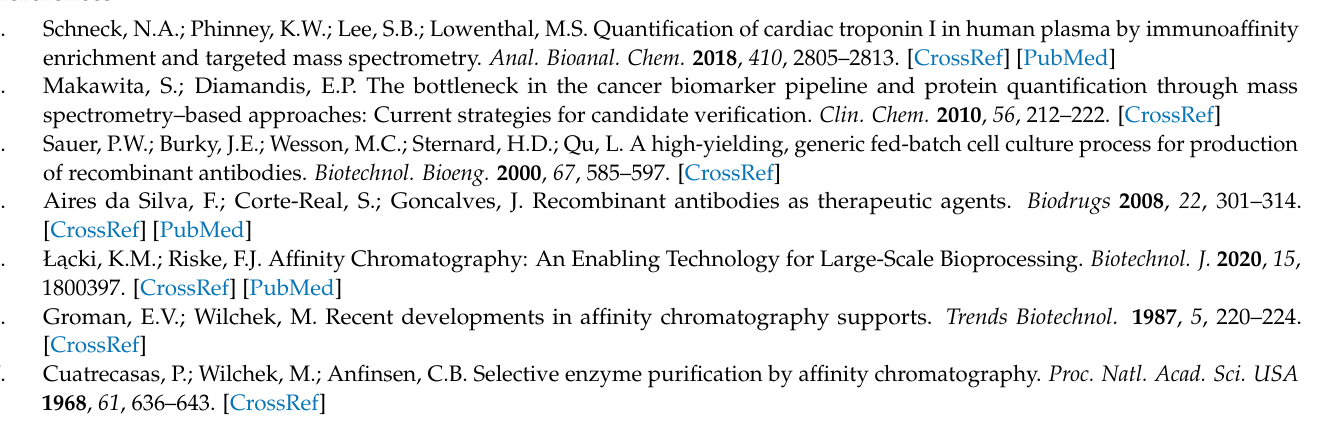
(DLS) measurements of corundum F1200 in 0.1 M PBS indicated an average particle size of 0.78 µ m; Figure S2: TEM micrograph of unpurified corundum: (a) Corundum surface covered with needle- shaped crystals, (b) elemental mapping showing sodium- and chloride-containing structures; Figure S3: Purification protocol for corundum powder; Figure S4: TEM-EDS analysis of corun- dum before (black) and after (red) purification; Figure S5: BET measurements: Isotherm linear plot and BET surface area plot; Figure S6: Calibration line of tyrosine (amino acid standard solution). Fluorescence detection was performed at 272 nm (Ex.) and 303 nm (Em.); Figure S7: TEM-EDS analysis of corundum before (red) and after (black) 12-APA functionalization; Figure S8: NMR of untreated PG (red) and oxidized PG (blue). The NMR signal at a chemical shift of 9.5 ppm indicates terminal aldehydes of the polyglycerol that were formed due to oxidation with NaIO 4 . The very sharp singlet at a chemical shift of 8.3 ppm corresponds to formic acid, also a product of the cleav- age; Figure S9: ESEM micrographs of functionalized corundum. A surface layer was not visible; Figure S10: SDS-PAGE of corundum functionalized with bovine serum albumin (BSA), conjugated with glutaraldehyde or polyglycerol. The functionalized corundum was incubated with 1:10 diluted human plasma (HP). After the elution with 2% of SDS, almost no protein elution was detected for the polyglycerol/BSA-functionalized corundum, whereas for the glutaraldehyde/BSA, at least one weak protein band (arrow) is visible. Furthermore, no elution (leaching) of the covalently bound BSA was